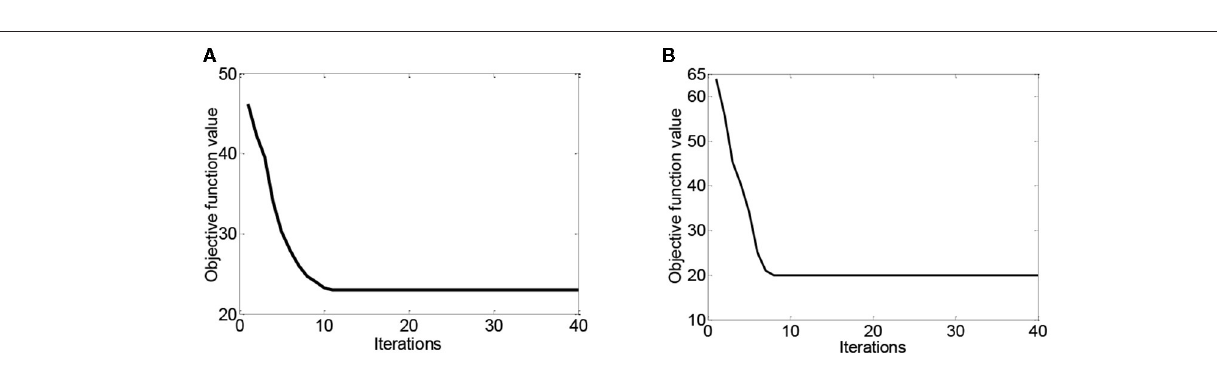
evident differences, with three domain adaptation methods show significant improvements in classification accuracy. Second, EEG emotion classifications. DASRC achieves 16.88%